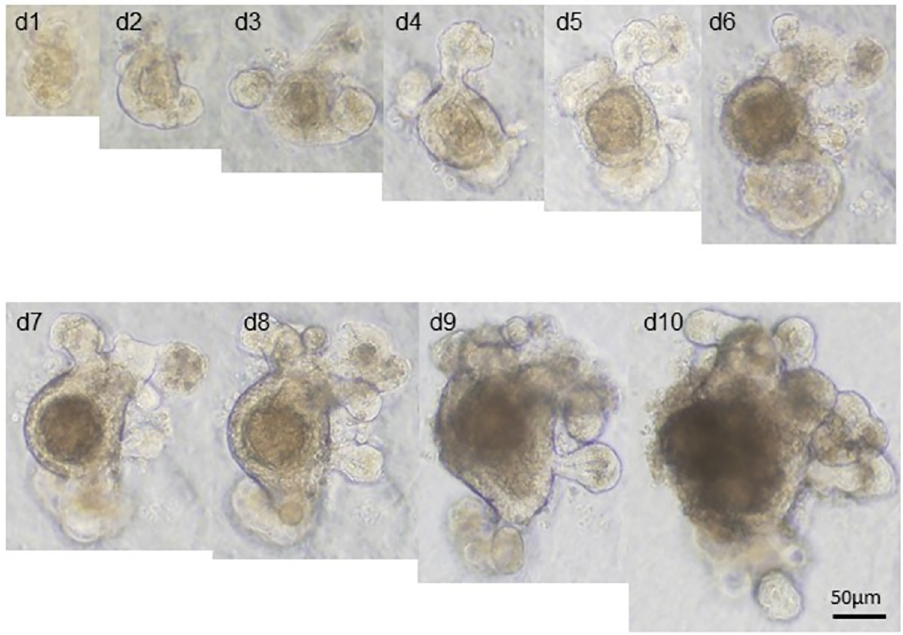
Fig 2. Three-dimensional morphology of the cultured “mini-gut” organoids. (A) Z-stack serial images of a multi- budding organoid. The bottom-to-top distance was 225 μ m with 25 μ m distance interval between images. (B) Monitoring the growth of a single organoid over a period of 10 days in 3-D Matrigel culture. Representative images are